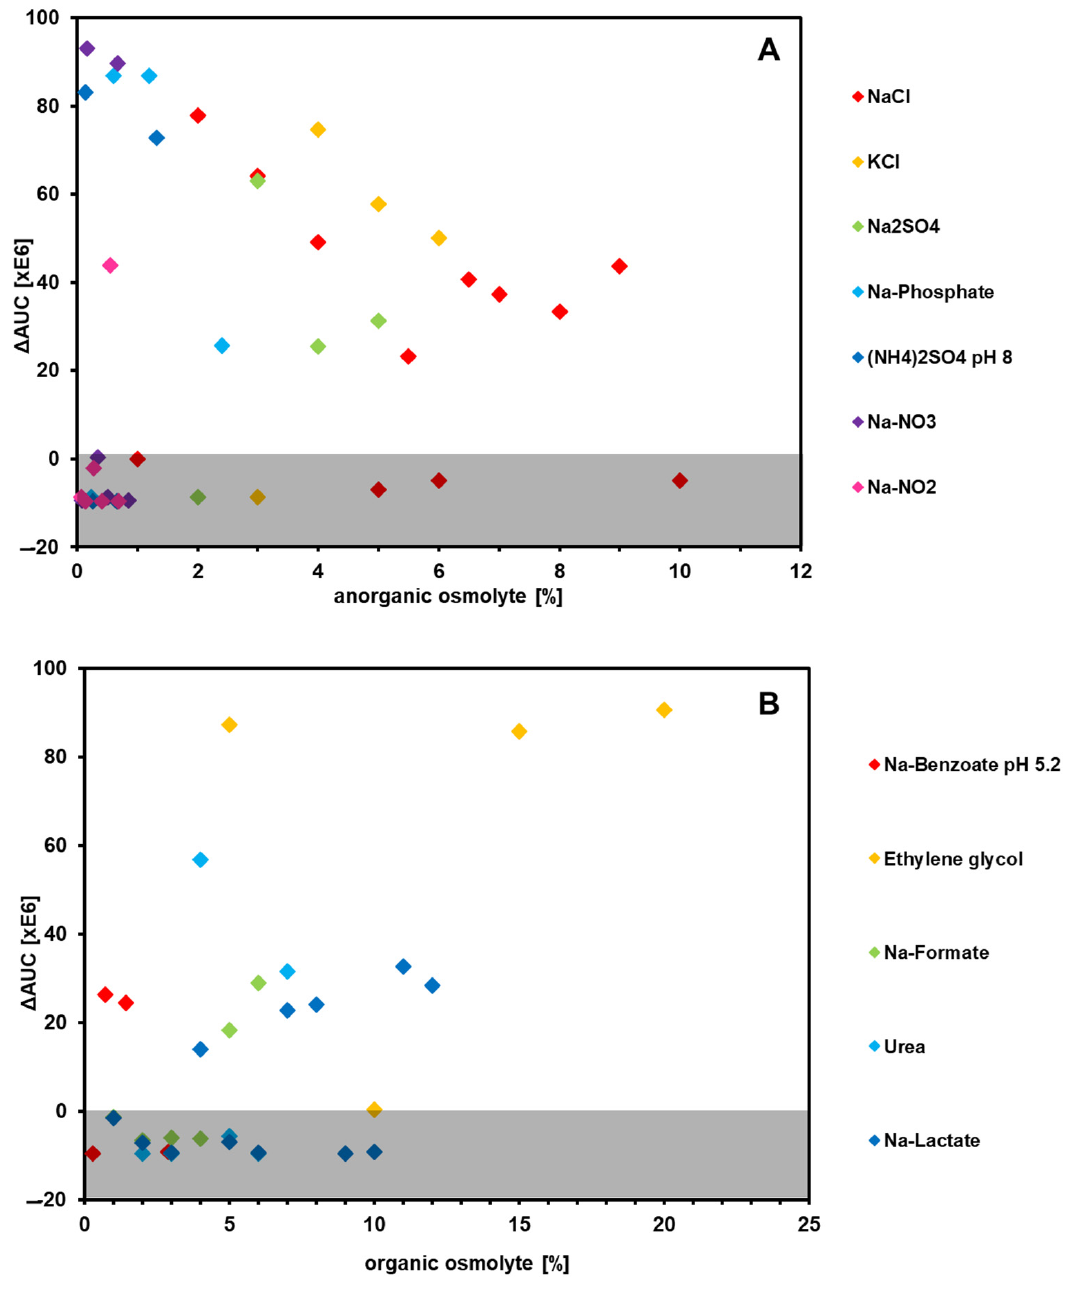
Figure 5. Diagrams of ∆ AUC (area under a curve) values against the amount of osmolytes in percent. Shown are the values produced by inorganic salts ( A ) and organic compounds ( B ). The grey area shows all values below zero, indicating a negative effect on respiration, while all values above zero indicate a positive effect.